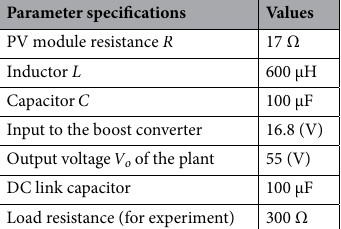
Table 5. Boost converter specifications.